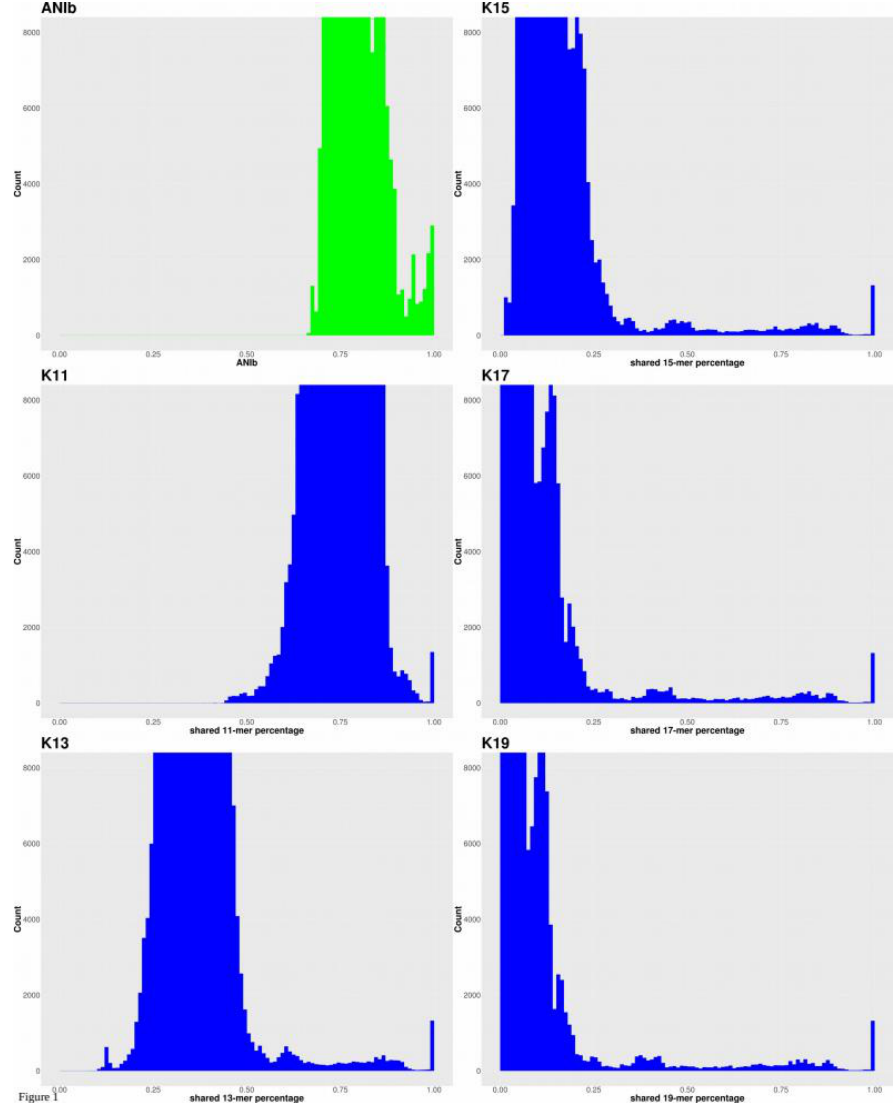
Figure 1. Distribution of shared k-mers values. Relatedness between genome sequences were estimated with ANIb (green) or shared k-mers (blue). The x axis represents ANIb or percentage of shared k-mers while the y axis represents the number of values by class in the subset of 934 Pseudomonas genomic